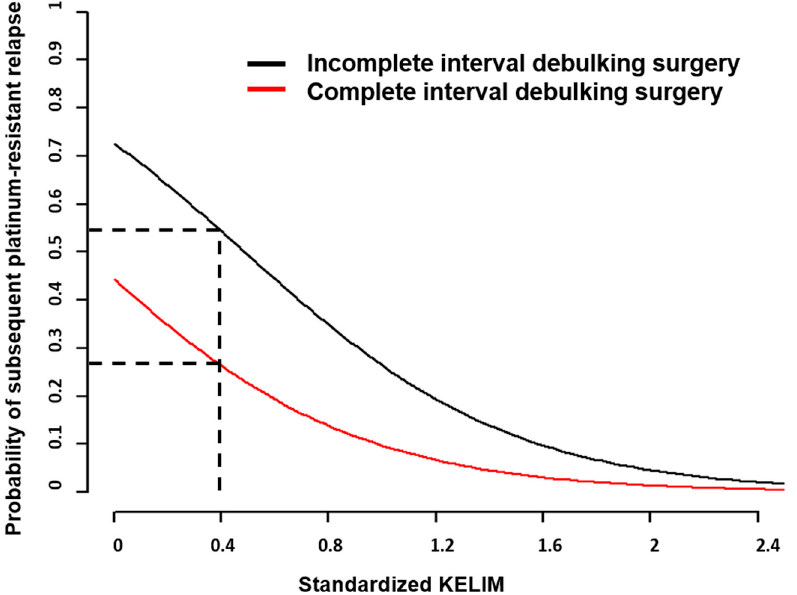
Figure 4. Platinum-Resistant Recurrence Score. Probability of subsequent platinum-resistant recur- rence according to std KELIM. Dashed black line: illustration of a patient with std KELIM = 0.4; the risk of platinum-resistant relapse probability of 26% if IDS was complete or 54% if IDS was incom- plete (Adjusted from You et al., Clin Cancer Res 2020 [27]).